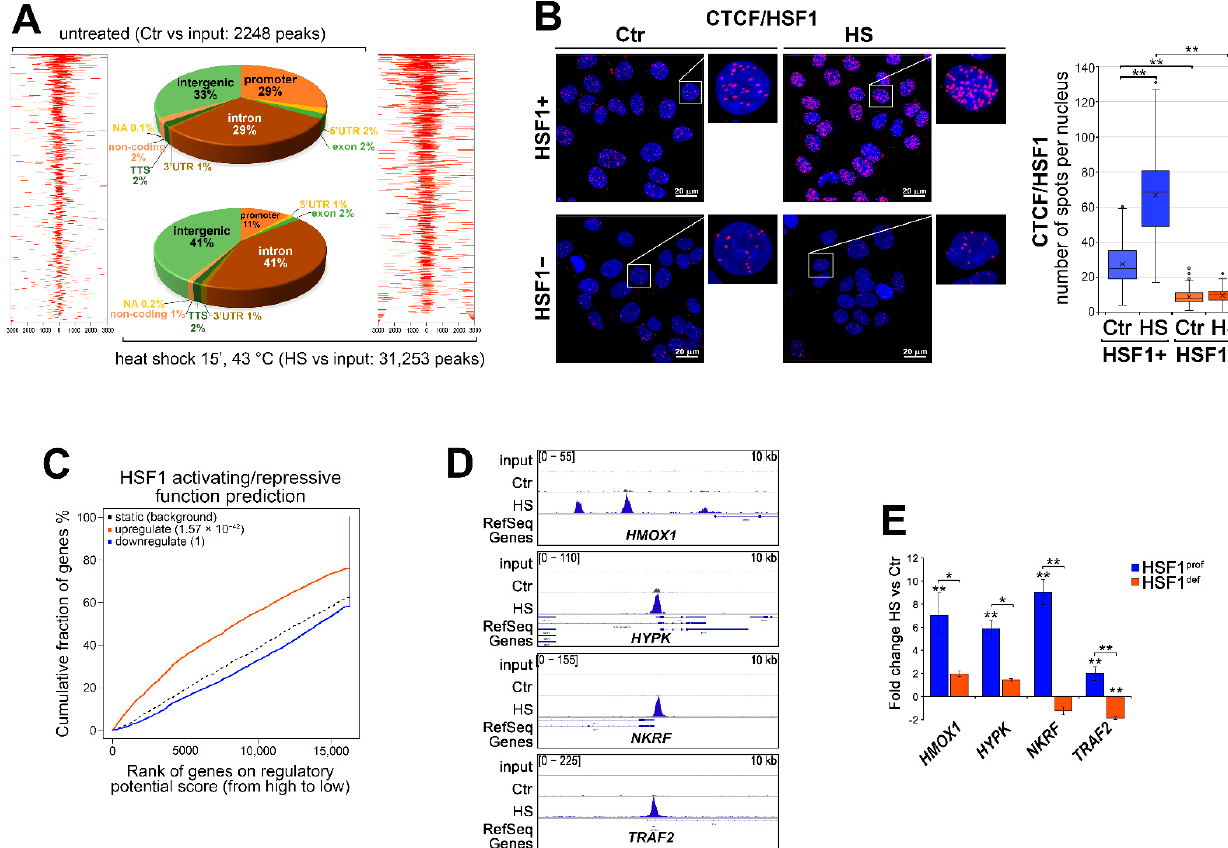
Figure 3. HSF1 binding across the genome is remodeled after heat shock in MCF7 cells possibly involving CTCF. ( A ) Heatmaps and distribution of HSF1 binding sites within different genomic regions in untreated and heat-shocked cells (based on ChIP-seq data). Heatmaps depict all HSF1 binding events centered on the peak region within a 3 kb window around the peak. Peaks in each sample were ranked on intensity. ( B ) Interactions between CTCF and HSF1 assessed by PLA (red spots) in MCF7 cells (HSF1 − cells serve as a negative control), untreated and after HS treatment (15 min at 43 °C). DNA was stained with DAPI. Scale bar, 20 μ m. Representative nuclei are enlarged. The number of spots per nucleus is shown in boxplots (which represent the median and the mean, upper and lower quartiles, maximum and minimum, and outliers). ** p < 0.001. ( C ) Prediction of activating/repressive function of HSF1 based on ChIP-seq and RNA-seq data integration using the BETA tool. The red, blue, and dashed lines represent the upregulated, downregulated, and nondif- ferentially expressed genes (as background), respectively. ( D ) Examples of HSF1 peaks identified in ChIP-seq analyses and visualized by the IGV browser in untreated cells (Ctr) and after heat shock (HS). The scale for each sample is displayed in the left corner, length of the region shown—in the right corner. ( E ) Changes in expression of genes activated after heat shock in HSF1 prof but not in HSF1 def cells (extracted from RNA-seq data). ** p < 0.001, * p < 0.05 (significance of differences versus the corresponding control or between cell variants).